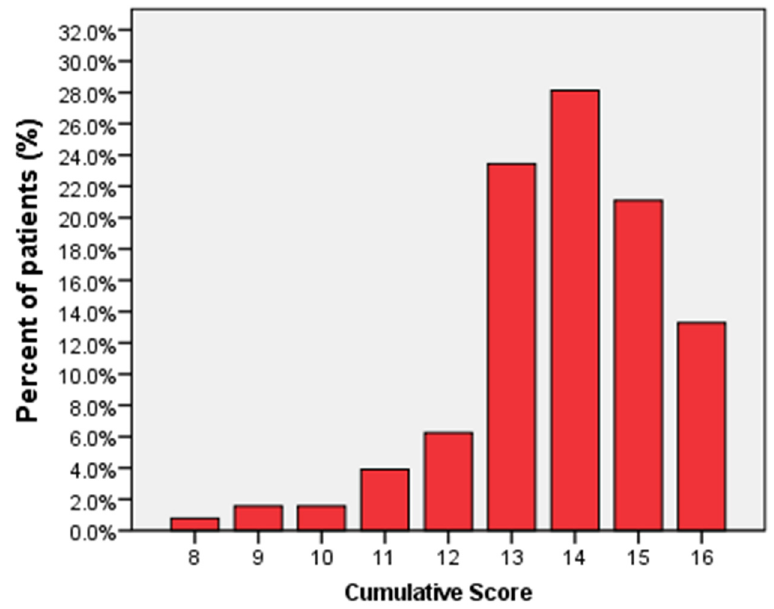
Figure 3. Distribution of CS values in the COVID-19 prospective cohort.